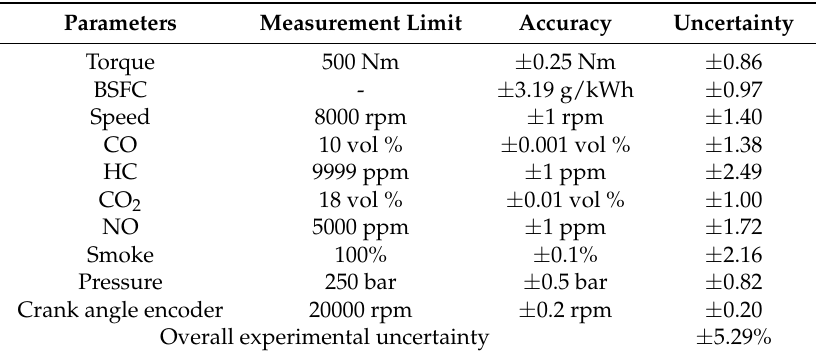
Table 5. The accuracies and uncertainties of the measured